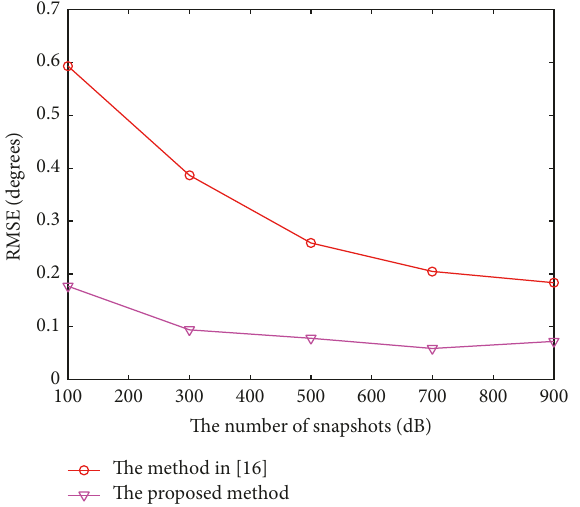
Figure 8: Angular resolution ability as a function of SNR.